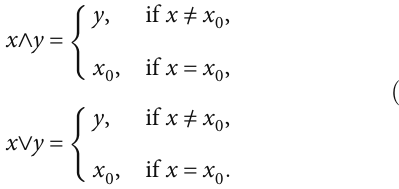
Figure 3: The Boolean lattice diagram.